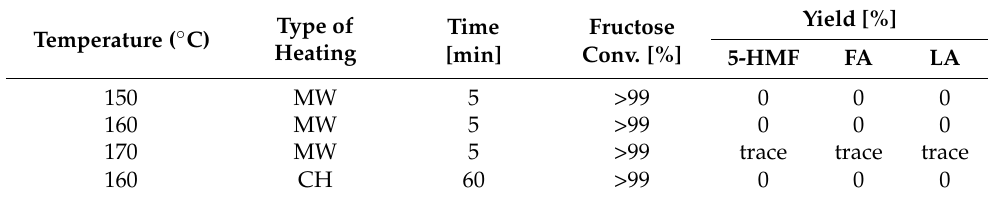
Table 3. Non-catalytic fructose dehydration into 5-HMF. Reaction conditions: MW via the